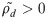
(A) Reciprocity scores (ρd) for within-bout (Δ < 0) grooming by dyad (d): 32 out of 128 dyads exhibit significant asymmetry in grooming durations (ρd˜>0) at p = 0.05; (B) Reciprocity scores (ρd) for delayed (Δ ≥ 0) grooming: all dyads show significant asymmetry (ρd˜>0) at p = 0.05.